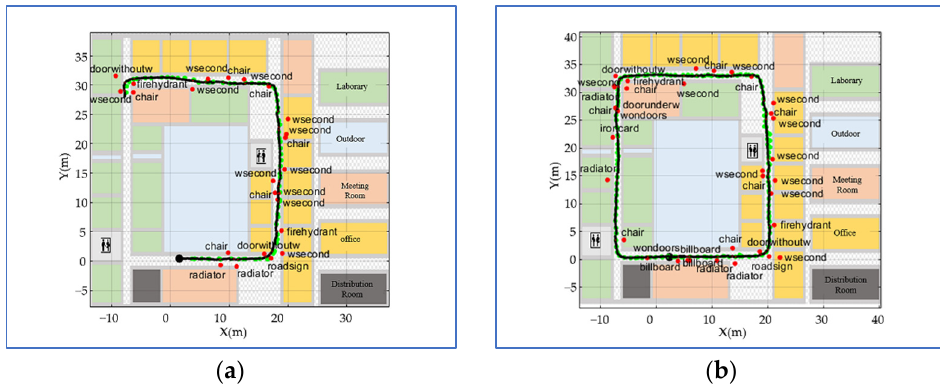
Figure 9. The comparison between the initial and fused venue maps in the office building scene. ( a ) The initial venue map, and ( b ) the fused venue map.